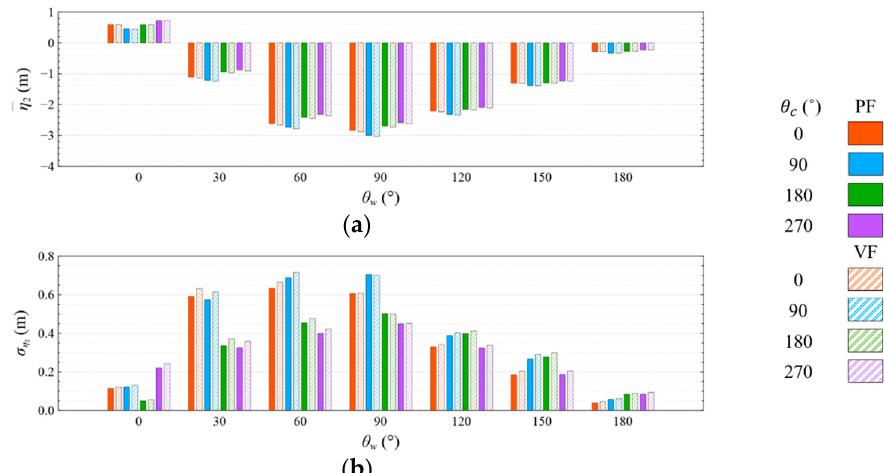
Figure 22. Comparison of ( a ) means and ( b ) standard deviations of platform sway motion under HW condition.